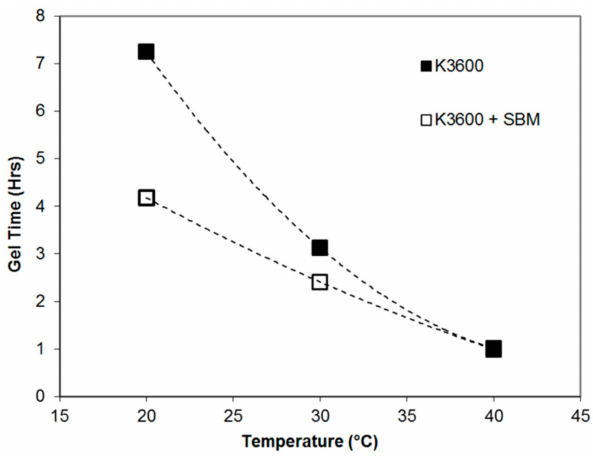
Figure 4. Gel time results as a function of cure temperature for neat and toughened resin systems.